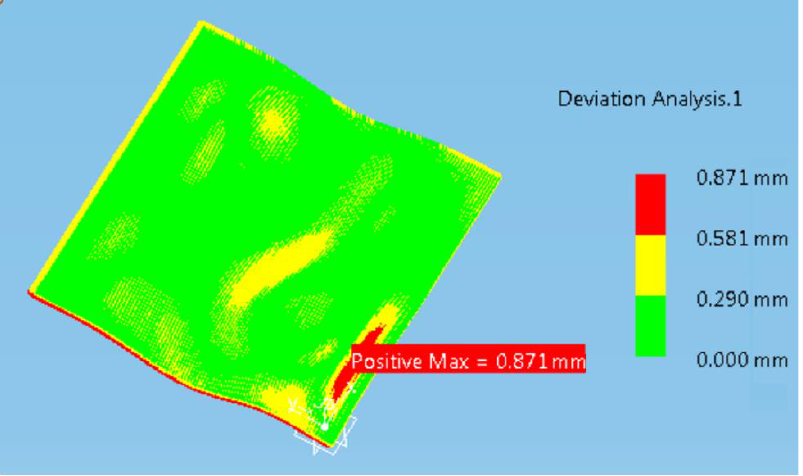
Figure 10. Comparative analysis result between generated surface and the measured surface with non-contact, laser 3D scanning (unordered point cloud).